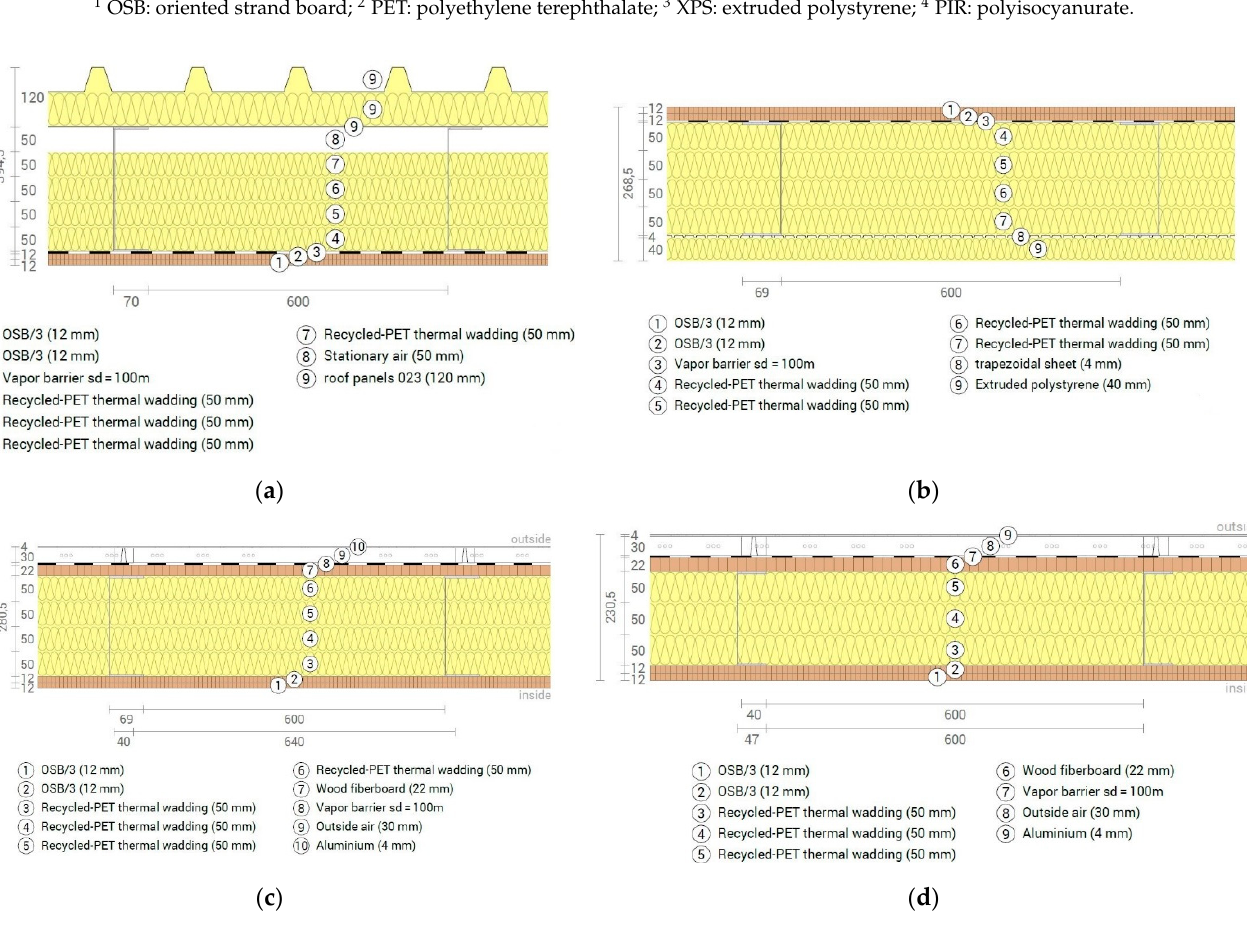
The structure is proper for various envelope configurations. The current envelope configuration (Figure 8) was carefully selected with consideration for the local sourcing of building materials to keep transport emissions and associated costs to a minimum.